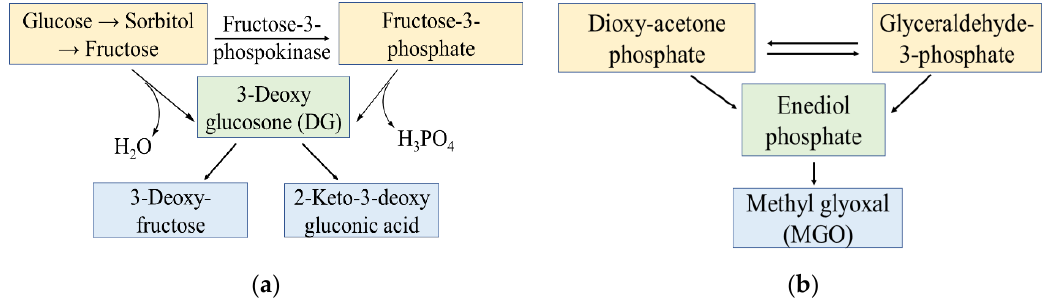
Figure 2. The RCS generation via polyol pathway ( a ); and glycolysis pathway ( b ).